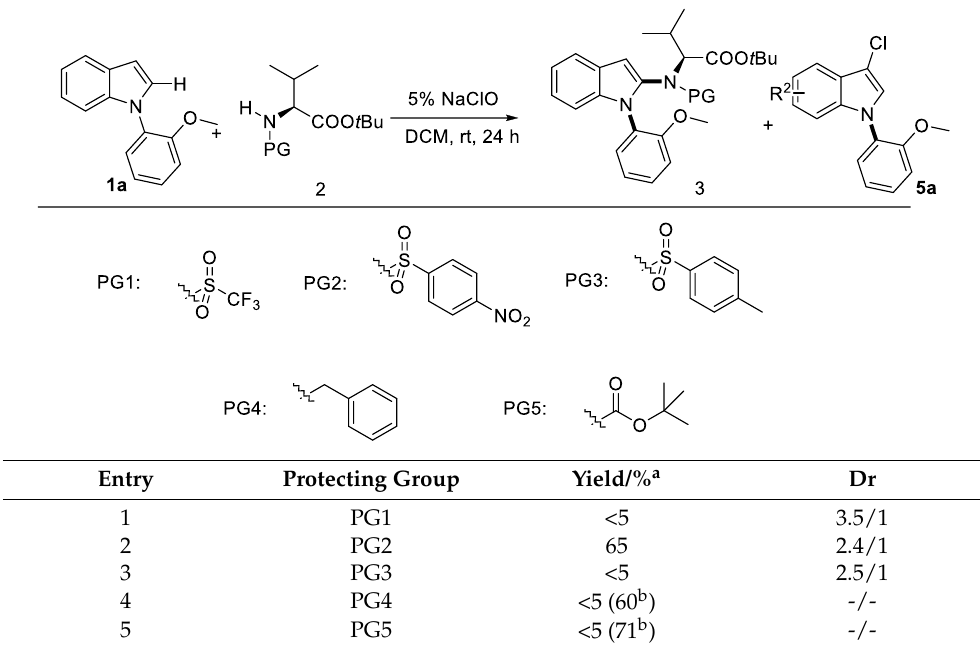
Table 2. Protecting group screening for indole C – N axially chiral construction.